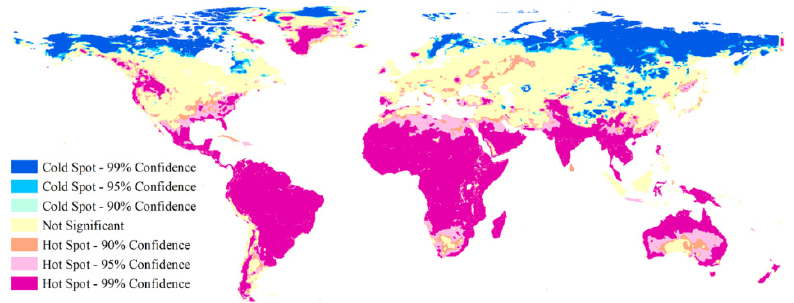
Figure 4. Spatial pattern of change rates of global heating degree days from 1970 to 2018 based on hotspot analysis.